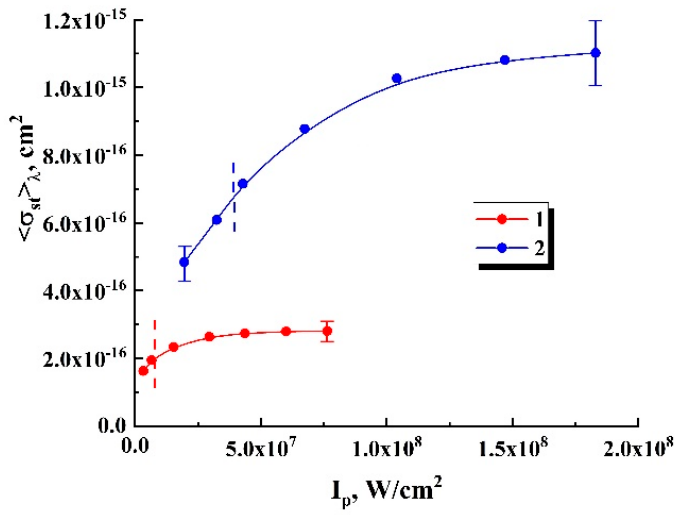
σ of fluorophore of fluorophore λ st λ